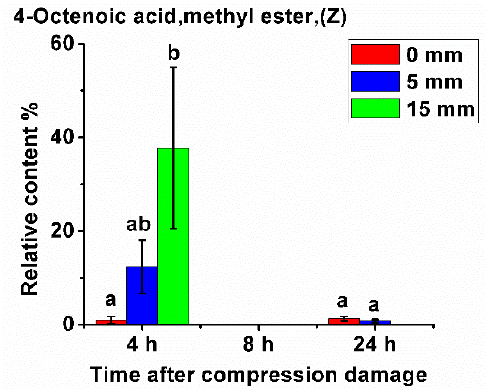
Figure 4. Relative content of 4-(Z)-octenoic acid methyl ester after compression damage.